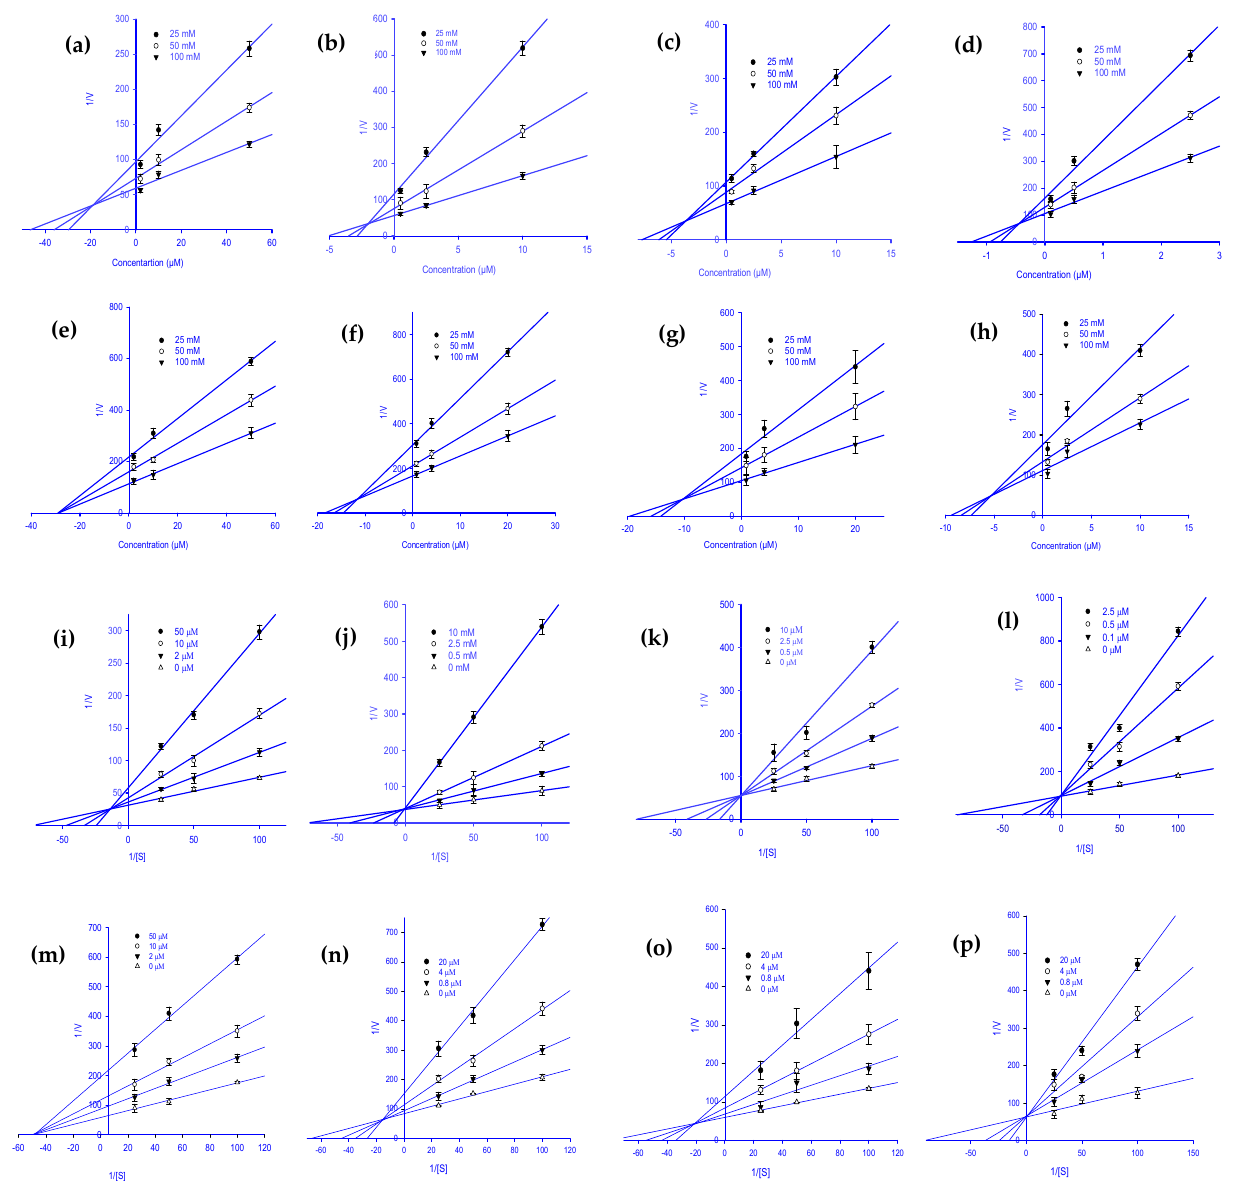
Figure 2. Dixon plots for RLAR inhibition by various ginsenoside derivatives. Protopanaxadiol ( a ), (20S) ginsenoside Rg3 ( b ), (20 R ) ginsenoside Rg3 ( c ), ginsenoside Rh2 ( d ), protopanaxatriol ( e ), ginsenoside Rf ( f ), (20 S ) ginsenoside Rg2 ( g ), and ginsenoside Rh1 ( h ) were tested in the presence of 25 mM (●), 50 mM ( ○ ), and 100 mM ( ▼ ) substrate ( DL -glyceraldehyde). Lineweaver-Burk plots for RLAR inhibition were analyzed in the presence of the following ginsenoside concentrations: 0 µM (Δ), 2 µM ( ▼ ), 10 µM ( ○ ), and 50 µM (●) for protopanaxadiol ( i ); 0 µM (Δ), 0.5 µM ( ▼ ), 2.5 µM ( ○ ), and 10 µM (●) for (20 S ) ginsenoside Rg3 ( j ); 0 µM (Δ), 0.5 µM ( ▼ ), 2.5 µM ( ○ ), and 10 µM (●) for (20 R ) ginsenoside Rg3 ( k ); 0 µM (Δ), 0.1 µM ( ▼ ), 0.5 µM ( ○ ), and 2.5 µM (●) for ginsenoside Rh2 ( l ); 0 µM (Δ), 2 µM ( ▼ ), 10 µM ( ○ ), and 50 µM (●) for protopanaxatriol ( m ); 0 µM (Δ), 0.8 µM ( ▼ ), 4 µM ( ○ ), and 20 µM (●) for ginsenoside Rf ( n ); 0 µM (Δ), 0.8 µM ( ▼ ), 4 µM ( ○ ), and 20 µM (●) for (20 S ) ginsenoside Rg2 ( o ); 0 µM (Δ), 0.5 µM ( ▼ ), 2.5 µM ( ○ ); and 10 µM (●) for ginsenoside Rh1 ( p ).